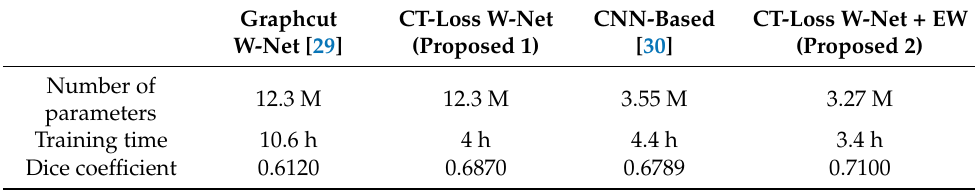
Table 1. Performance comparison results of cervical ROI segmentation.